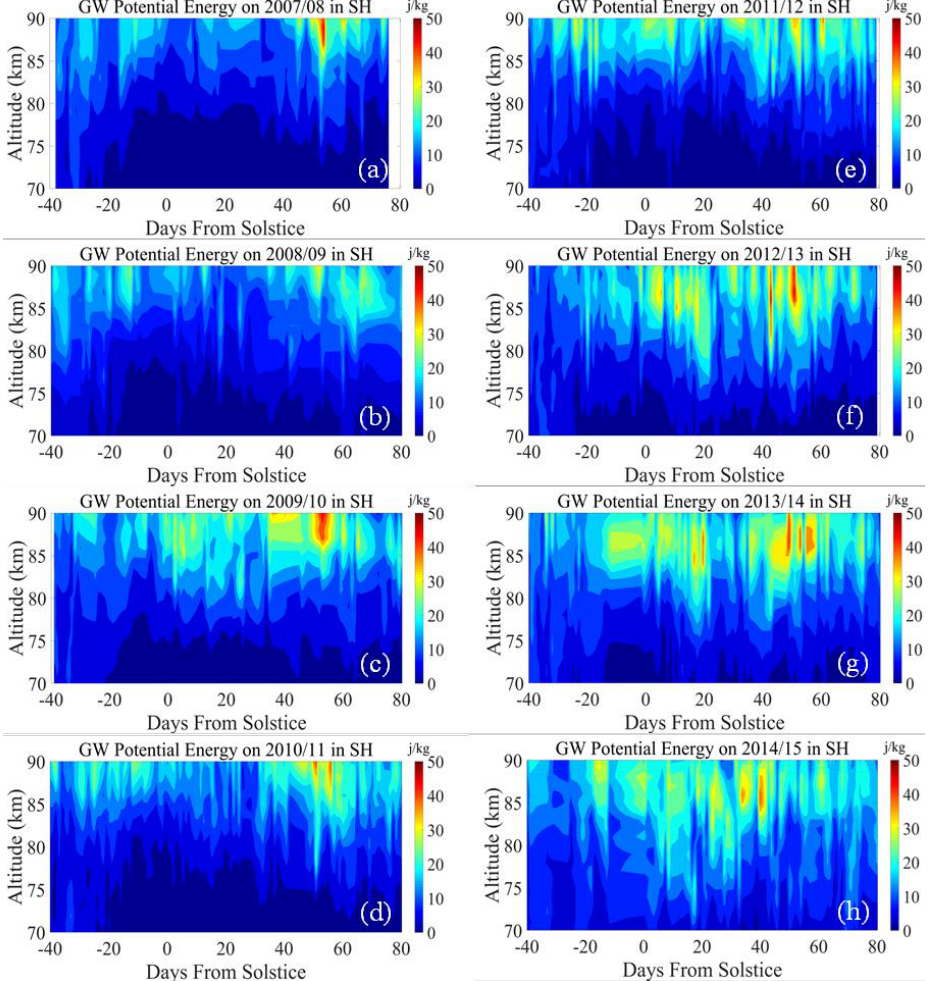
Figure 2. The GW potential energy distribution in the SH PMC seasons from 2007/2008 to 2014/2015. (a) GW potential energy on 2007/2008 PMC season; (b) GW potential energy on ( a ) GW potential energy on 2007/2008 PMC season; ( b ) GW potential energy on 2008/2009 PMC 2008/2009 PMC season; (c) GW potential energy on 2009/2010 PMC season; (d) GW potential en- season; ( c ) GW potential energy on 2009/2010 PMC season; ( d ) GW potential energy on 2010/2011 ergy on 2010/2011 PMC season; (e) GW potential energy on 2011/2012 PMC season; (f) GW poten- PMC season; ( e ) GW potential energy on 2011/2012 PMC season; ( f ) GW potential energy on tial energy on 2012/2013 PMC season; (g) GW potential energy on 2013/2014 PMC season; (h) GW 2012/2013 PMC season; ( g ) GW potential energy on 2013/2014 PMC season; ( h ) GW potential energy potential energy on 2014/2015 PMC season. on 2014/2015 PMC